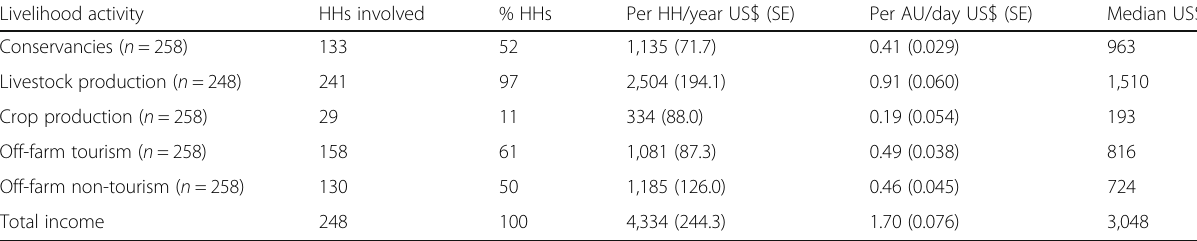
Table 3 Mean incomes from the different livelihood activities and mean total household income Livelihood activity